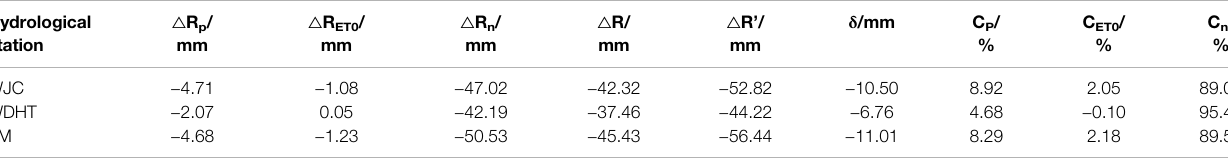
TABLE 3 | Attribution of runoff change in the Kuye River basin. Hydrological station